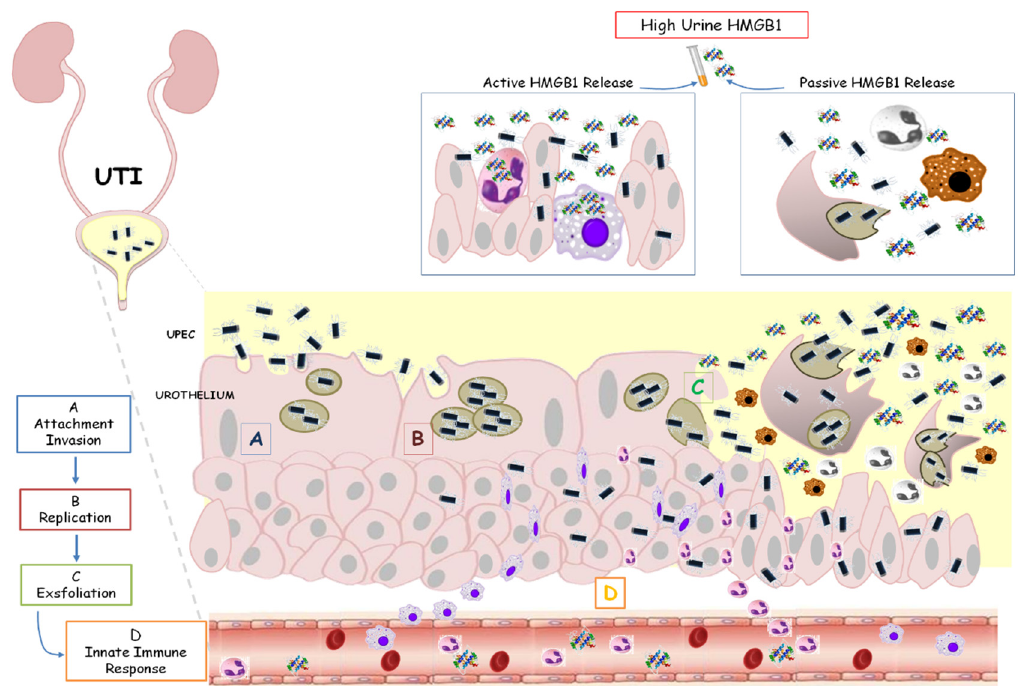
Figure 4. HMGB1 involvement in urinary tract infection. Uropathogenic Escherichia coli (UPEC) binds and invades the urothelium ( A , B ). Host inflammatory responses begin to clear extracellular bacteria. However, some bacteria evade the immune system, producing toxins and proteases that induce host cell damage with a final cell exfoliation ( C ). The activation of the innate immune system is based on the secretion of chemical mediators, such as chemokines and cytokines ( D ). In this contest, HMGB1 is passively released into urine from damaged or necrotic cells or actively released from activated cells, such as inflammatory cells and immune cells. High urine levels of HMGB1 characterized children with lower UTI.